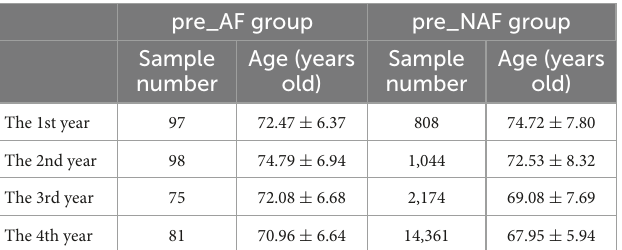
TABLE 1 Distribution of subjects’ number and age during follow-up.